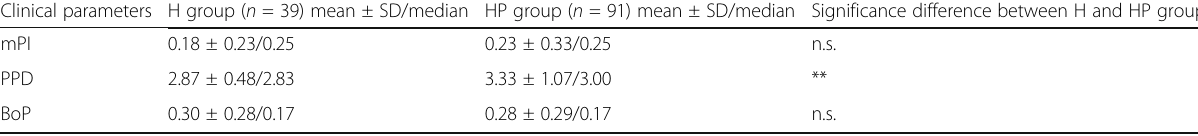
Table 4 Value of each clinical